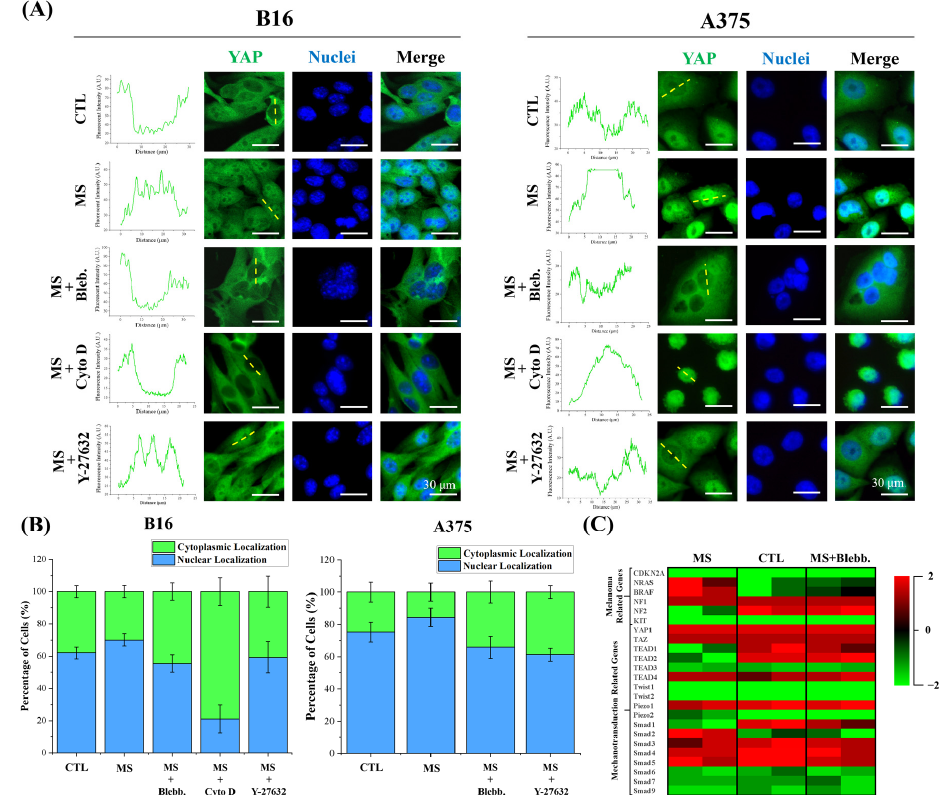
Figure 7. Influence of cyclic straining and inhibitors on YAP localization and gene expression. ( A ) Representative fluorescent images of YAP and nuclei-stained melanoma cells. ( B ) Quantitative data for YAP localization ( n = 3). ( C ) Heat map of RNA sequencing transcriptome analysis for selected genes. Data are presented as means ± SDs, ** p < 0.01.